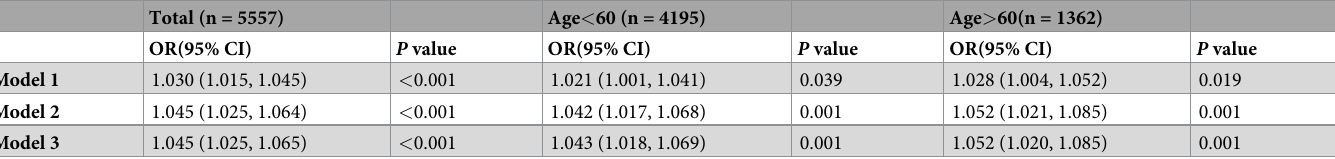
Table 3. Risks of diverticulosis between percentage of body fat and age.